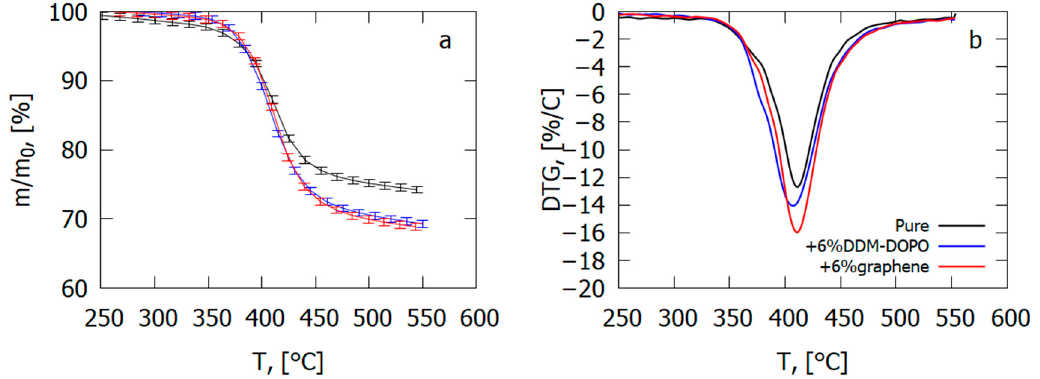
Figure 24. Thermal analysis data (( a )—TG, ( b )—DTG) for GFRER composites with the addition of 6% DOPO-DDM or 6% graphene and without it.